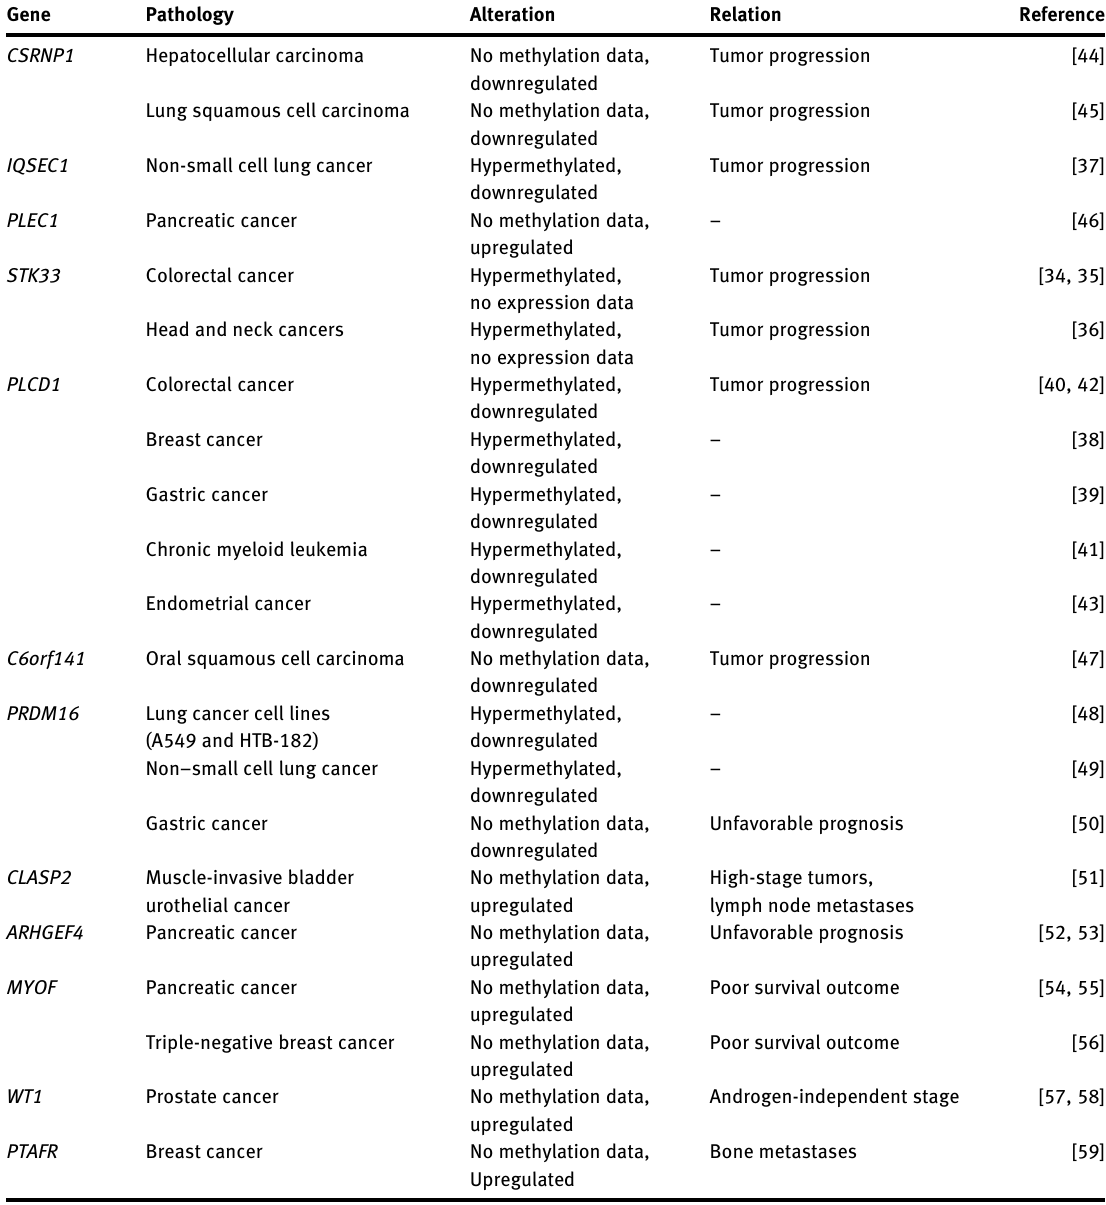
Table  : Methylation and gene expression data reported for identi fi ed genes.